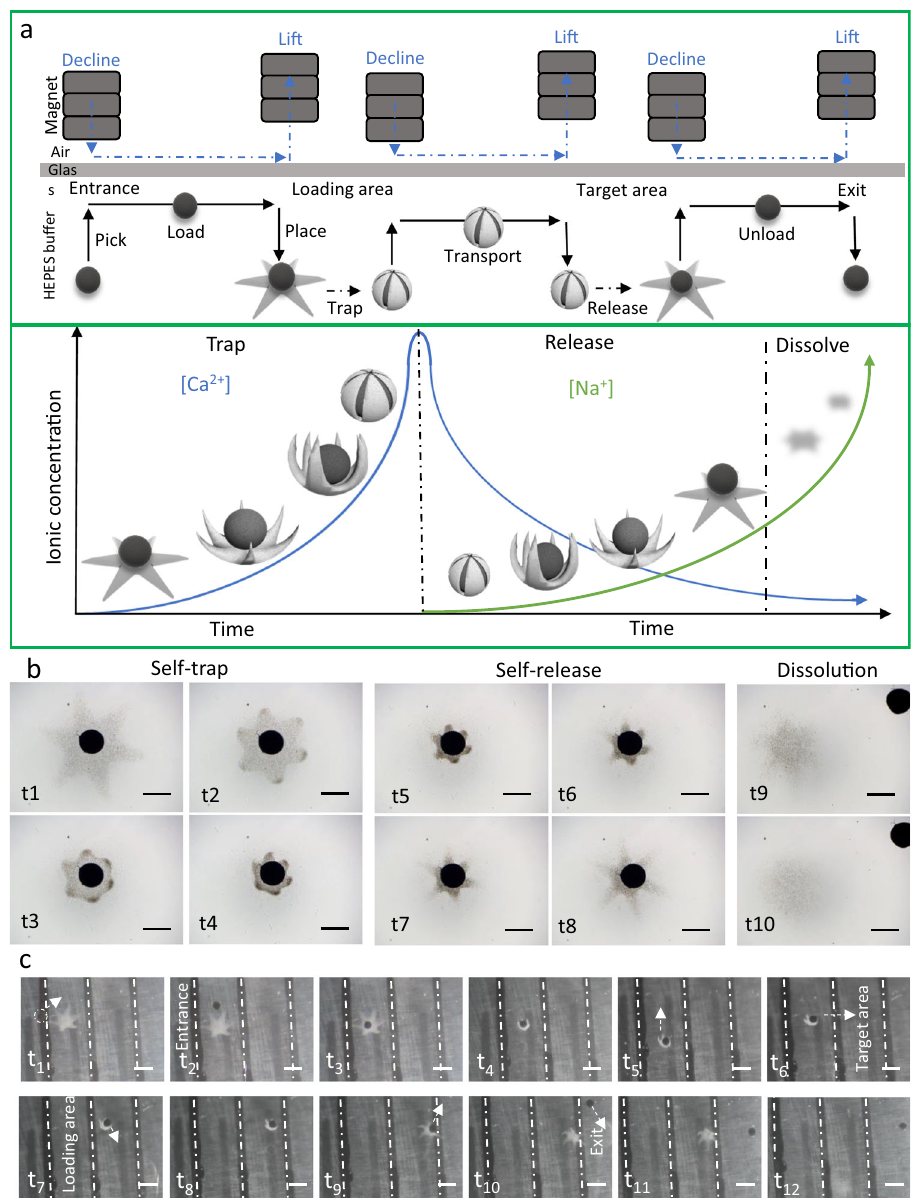
Fig. 6 Magnetic manipulation of an ISME through self-trapping magnetic microspheres. a Illustration of the cargo transportation task and corresponding ISME transformations under ionic stimulation. b Images of ISME self-trapping a magnetic microsphere upon application of a CaCl 2 solution and self- releasing the magnetic microsphere upon application of a sodium citrate solution followed by full dissolution. Scale bar: 500 μ m. c Side-view images of the cargo transportation task in HEPES buffer. Scale bar: 1